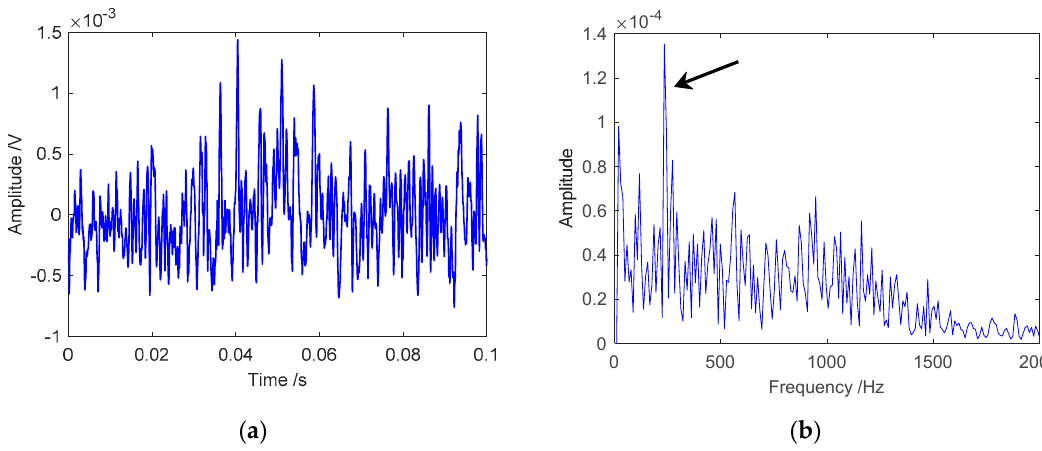
Figure 8. Results of the envelope demodulation: ( a ) The envelope waveform of latent component three; and ( b ) the corresponding envelope spectrum.